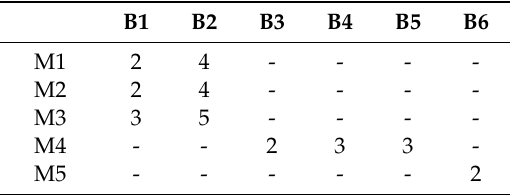
Table 7. Processing time with priority relation (PR) in DAG B.